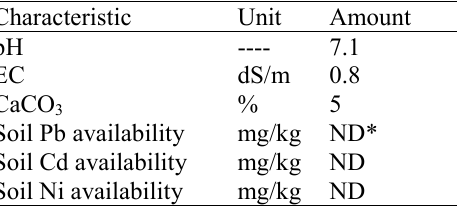
Table 1. Physicochemical properties of selected soil in this research Characteristic Unit Amount pH ---- 7.1 EC dS/m 0.8 CaCO 3 % 5 Soil Pb availability mg/kg ND* Soil Cd availability mg/kg ND Soil Ni availability mg/kg ND *Not detectable by atomic absorption spectroscopy